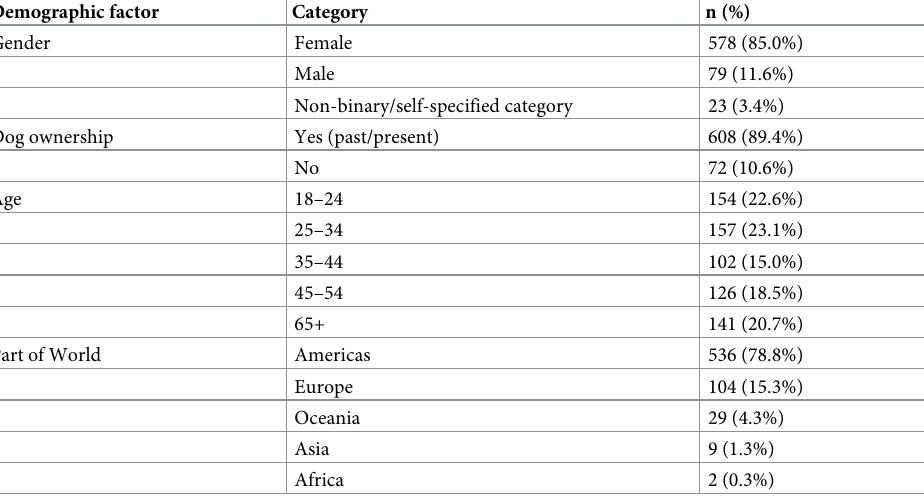
Table 1. Demographic factors of participants (n =